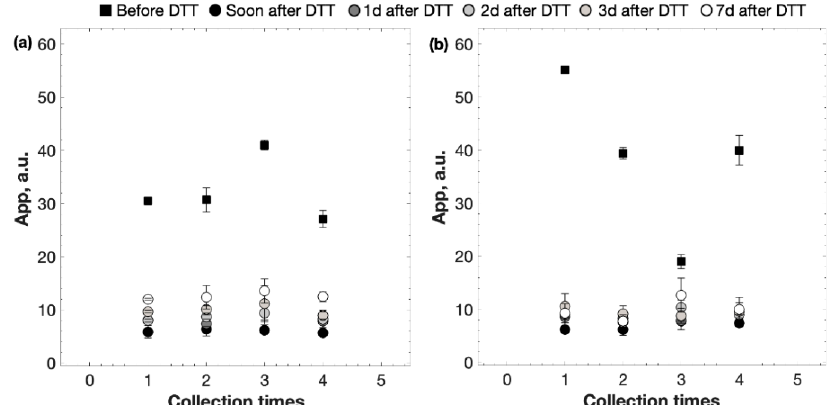
Figure 7. Changes in the background ESR signal (peak-to-peak amplitude, App) in unirradiated fingernail samples stored in the ( a ) vacuum chamber and ( b ) freezer measured before and after (soon, 1, 2, 3, and 7 days) the DTT